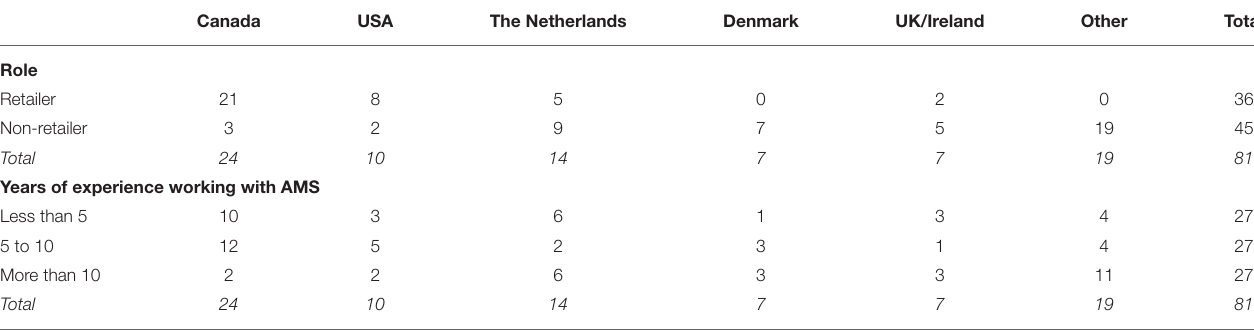
TABLE 3 | Number of respondents by country where they are primarily based compared to role and years of experience with AMS.